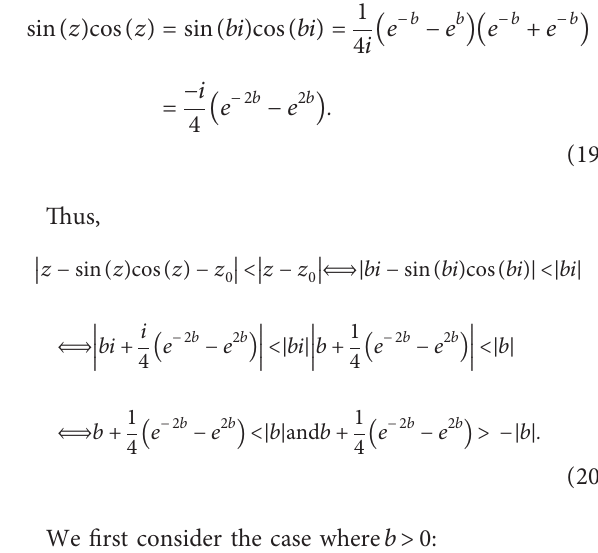
Figure 6: x - and y -axis symmetry of F